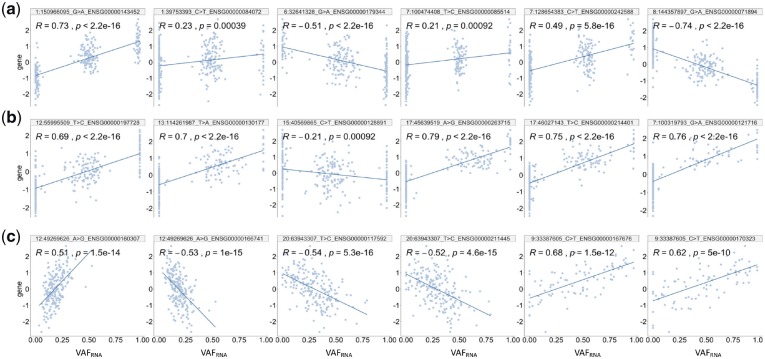
Correlation patterns identified by ReQTL analyses. (a) cis-ReQTL eQTL-like patterns. (b) cis-ReQTL patterns with non-extreme VAFRNA values spread along the regression line. (c) Trans-ReQTLs—a characteristic pattern with most of the VAFRNA values spread along the regression line